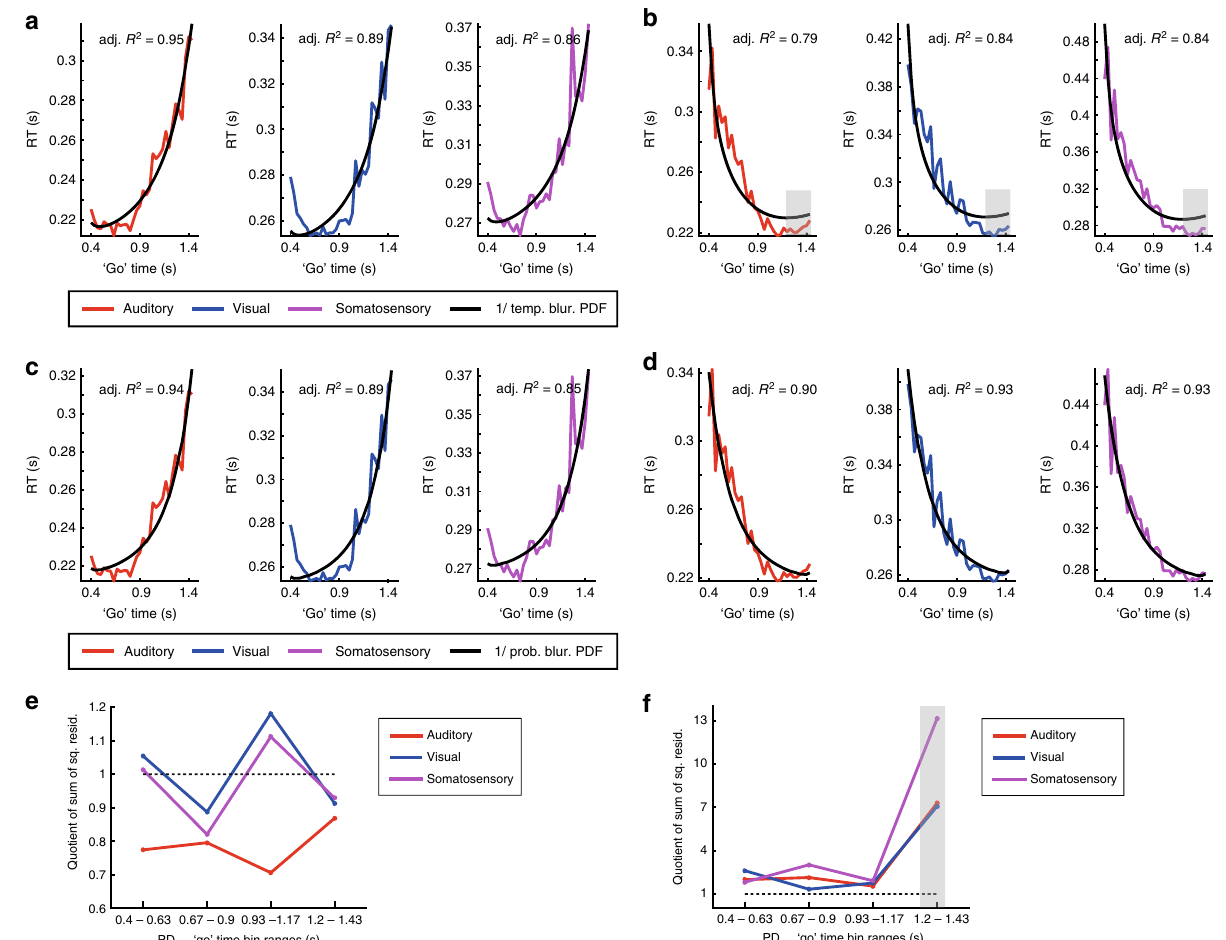
Fig. 4 Models based on probabilistically-blurred, reciprocal PDF capture reaction time (RT). a Model fi ts to auditory (red), visual (blue), and somatosensory (violet) RT based on the temporally-blurred, reciprocal PDF (black line) in the PD Exp condition. b As a but for PD Flip condition. Since temporal blurring increases with ‘ go ’ time, it has a stronger smoothing impact on the model at longer ‘ go ’ times. This feature is not re fl ected in the data ( ‘ go ’ time span 1.2 to 1.43 s highlighted). c Model fi ts to RT based on the probabilistically-blurred, reciprocal PDF in the PD Exp condition, d As c but for PD Flip condition. e Comparison between two reciprocal PDF-based models ( “ temporally-blurred ” and “ probabilistically- blurred ” ), in each of four equally spaced bins across the ‘ go ’ time span. e In the PD Exp condition, the quotient of squared residuals ( “ temporally-blurred ” / “ probabilistically-blurred ” ) is relatively close to 1 in all bins, indicating residuals of similar magnitude across the two models and thus a similar goodness-of- fi t. f As e but for the PD Flip condition, residuals are bigger in the temporally-blurred model compared to the probabilistically-blurred model in all bins, especially in bin #4 (highlighted). See Supplementary Figs. 1 and 3 for a detailed summary of all other fi tted PDF-based